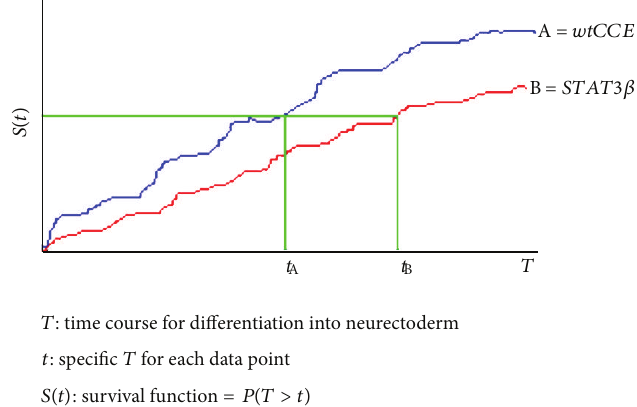
Figure 6: Theoretical sample of survival analysis data comparing the time it takes for wt CCE-GFP and STAT3 𝛽 -GFP ESCs to commit to the neuroectodermal fate (i.e., time Sox3 promoter -GFP is first expressed). Once differentiation data is acquired, the data could be plotted using graphviz at http://www.graphviz.org/ (last accessed